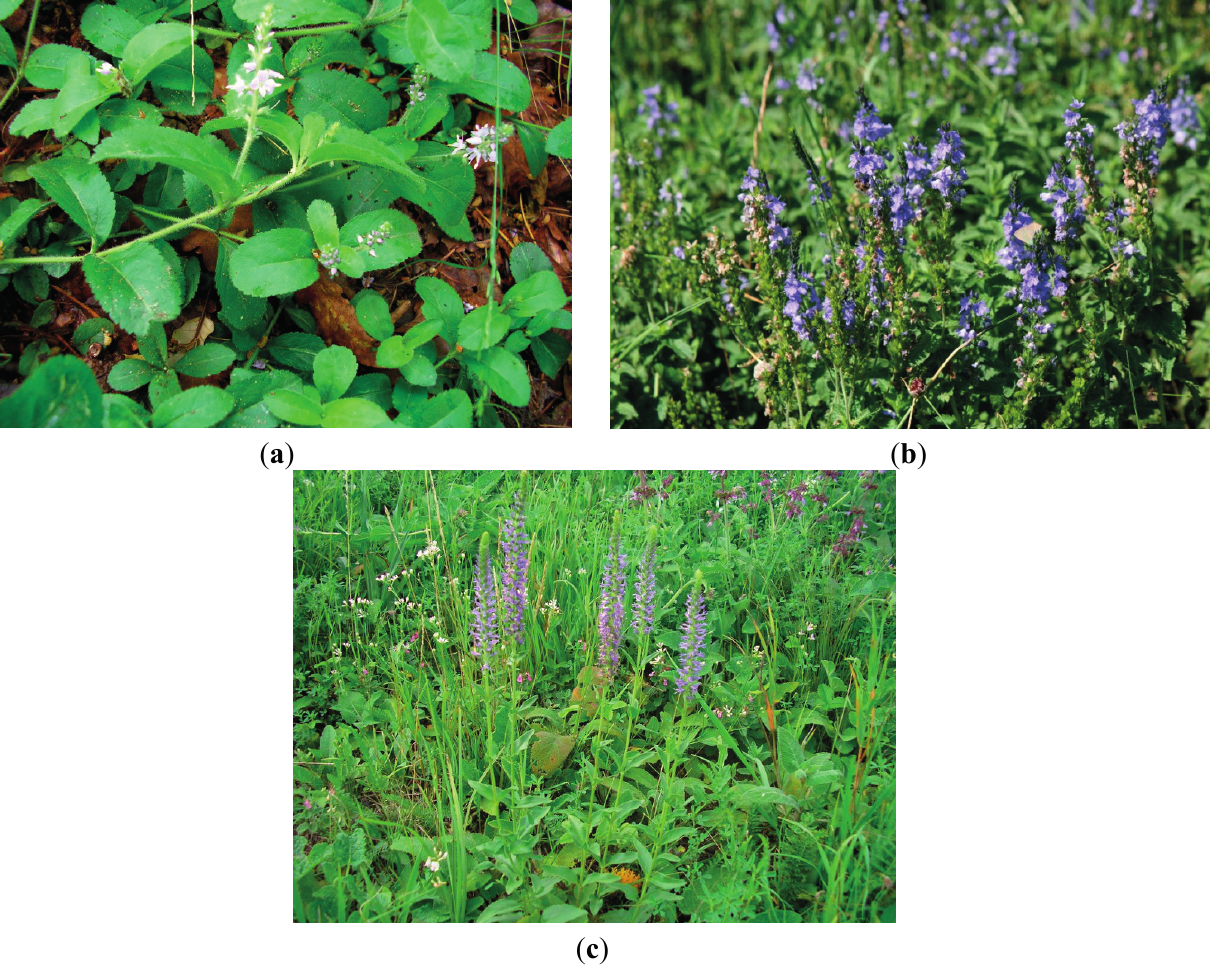
Figure 1. ( a ) V. officinalis L.; ( b ) V. teucrium L.; ( c ) V. orchidea